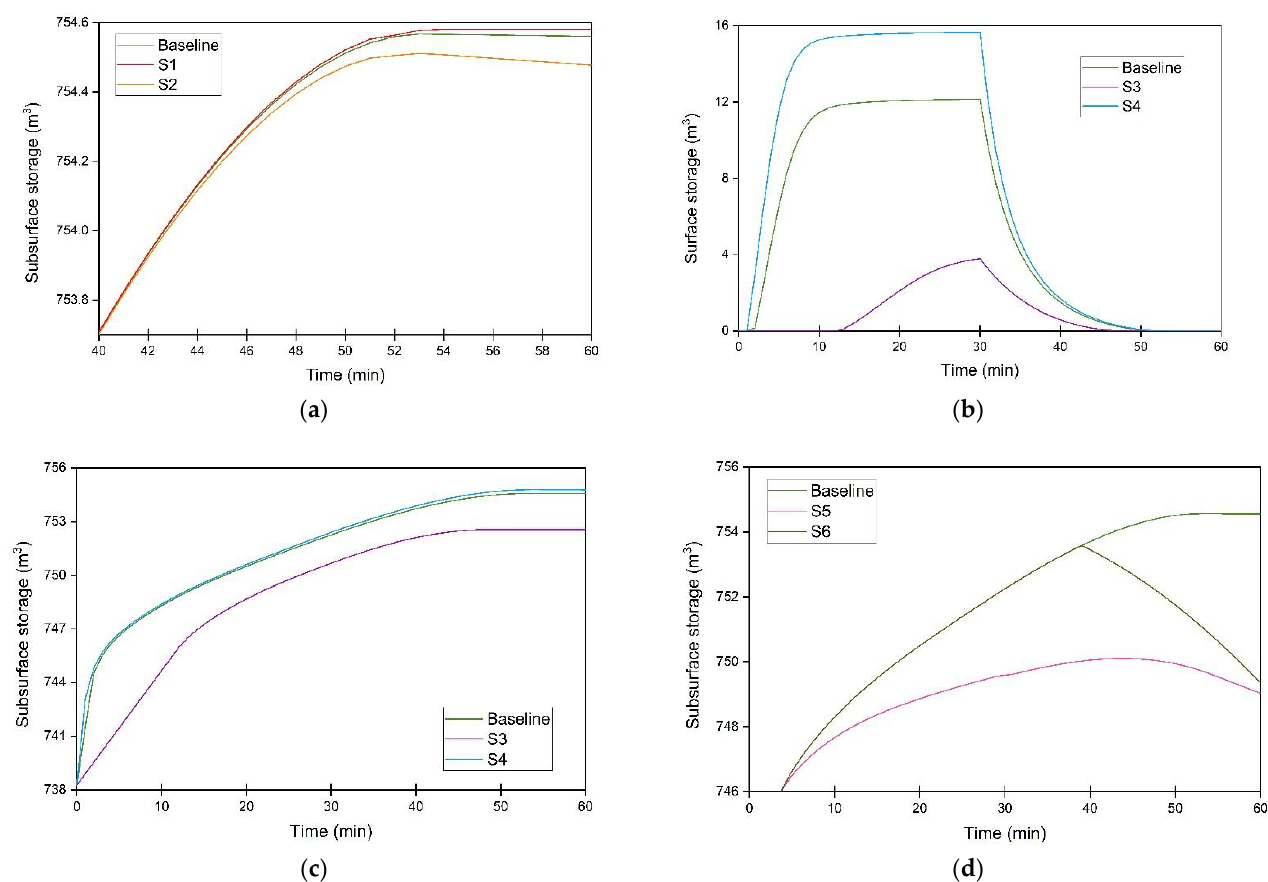
Figure 15. Comparison between storage time-series for the DYK case: ( a ) subsurface storage time- series of baseline, S1 and S2; ( b ) surface storage time-series of baseline, S3 and S4; ( c ) subsurface storage time-series of baseline, S3 and S4; ( d ) subsurface storage time-series of baseline, S5 and S6.